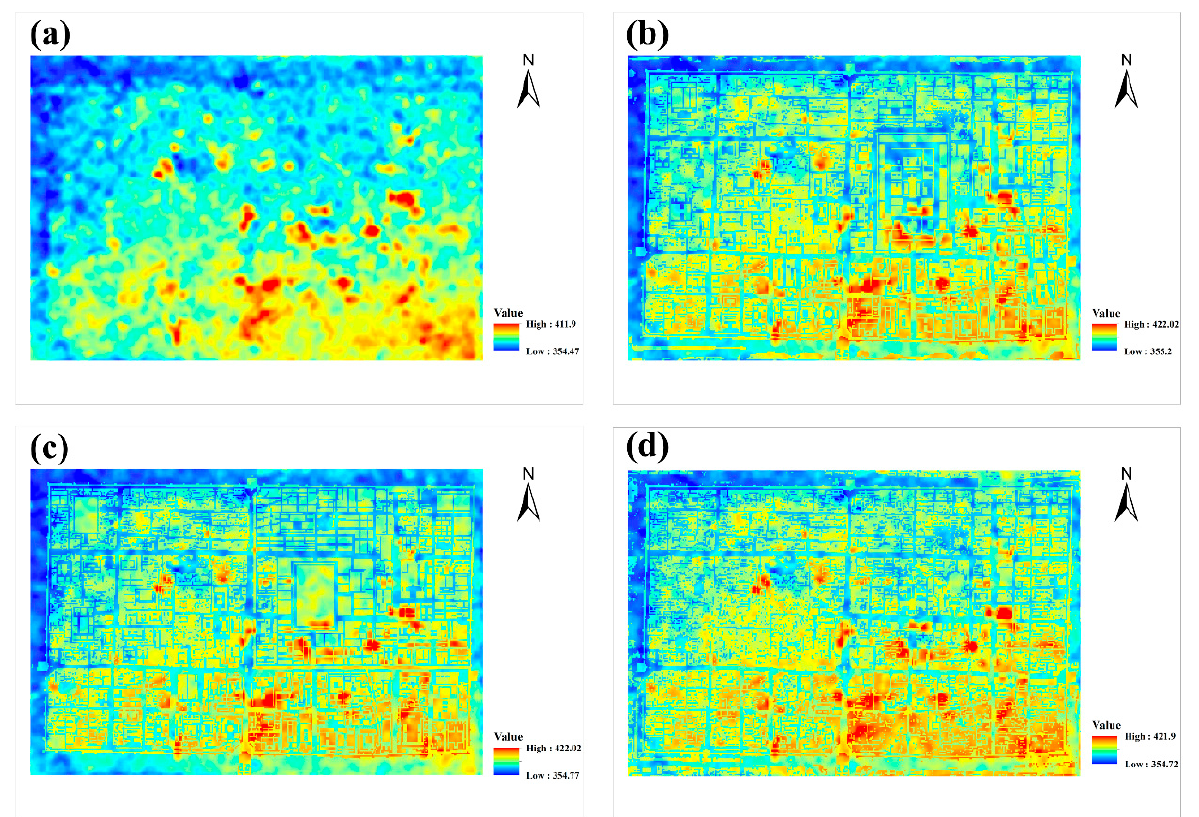
Figure 3. DEM of the study area. ( a ) Untreated; ( b ) Ming dynasty; ( c ) Qing dynasty; ( d ) Modern.